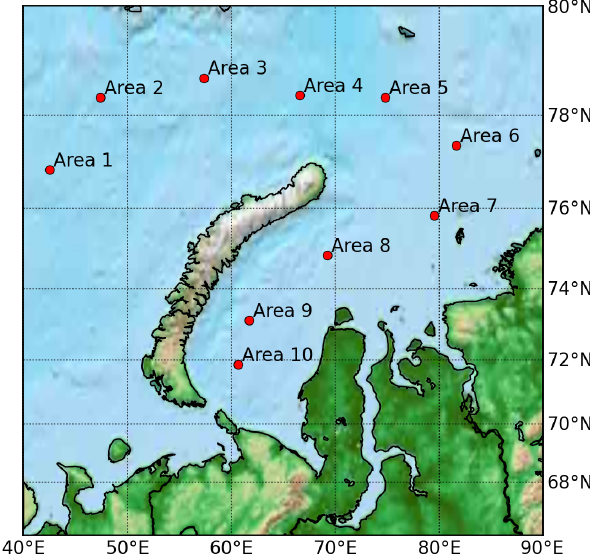
Fig. 3. Location of training areas.